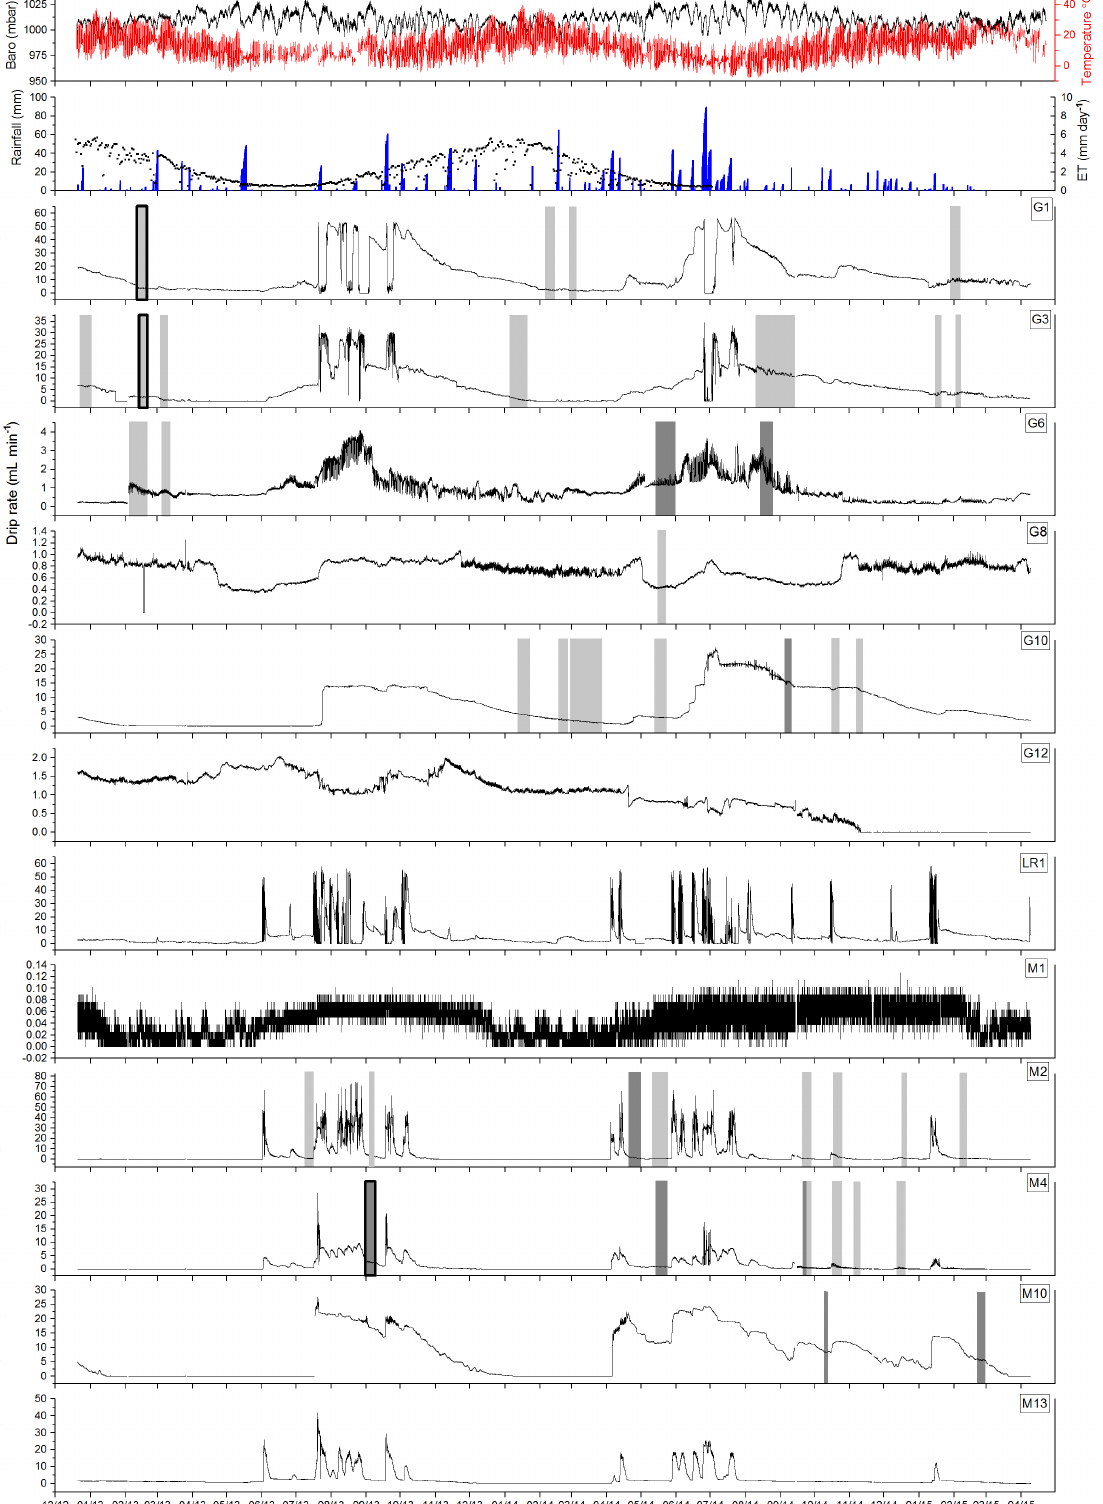
Figure 3. Drip discharge rate time series for all drip sites in Glory Hole Cave with periods where daily fluctuations occur highlighted in light grey (1cpd) and dark grey (1 and 2cpd). The time periods examined in more detail in Figs. 4–6 are indicated by bolder outline.